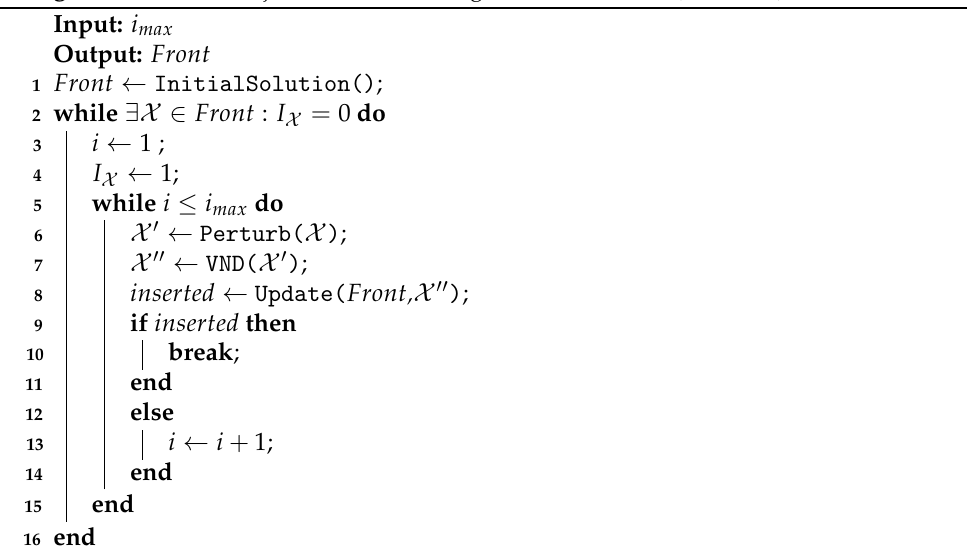
Algorithm 1: Multiobjective variable neighborhood search